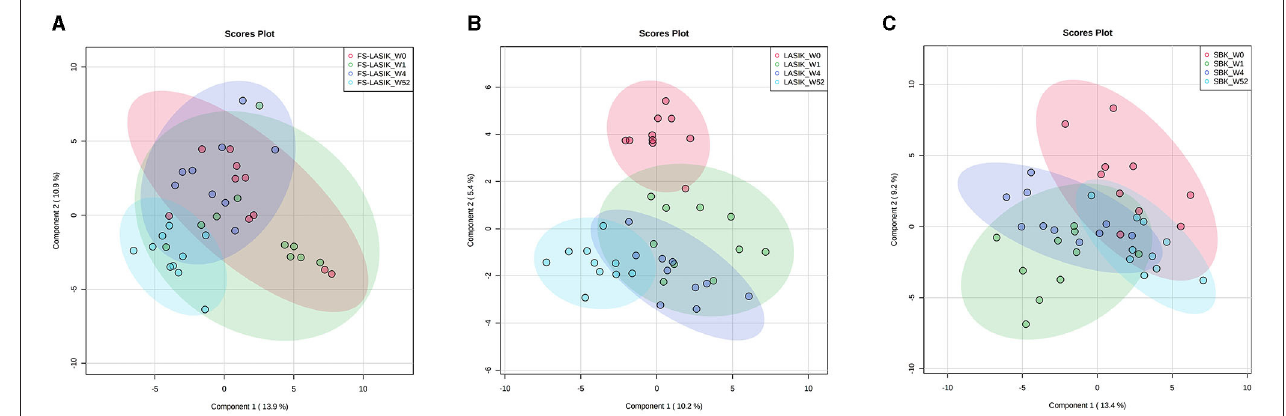
FIGURE 2 | The partial least squares-discriminant analysis (PLS-DA) score plots showing the lipid profiles in week 0, week 1, week 4, and week 52 from the FS-LASIK, LASIK, and SBK groups, respectively. (A) FS-LASIK; (B) LASIK; (C) SBK. Red circle: week 0; Green circle: week 1; Purple circle: week 4; and Blue circle: week